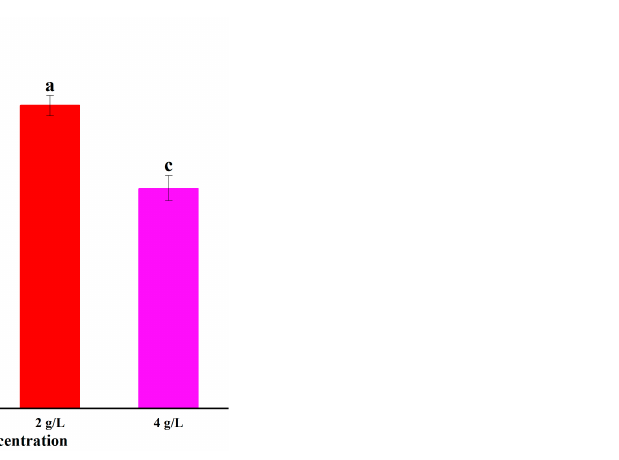
Figure 4. Degradation effect of abamectin at different bacterial concentrations. Error bars represent the standard deviation of three replicate experiments, and different letters indicate significant differences as determined by Waller-Duncan’s test ( P < 0.05).